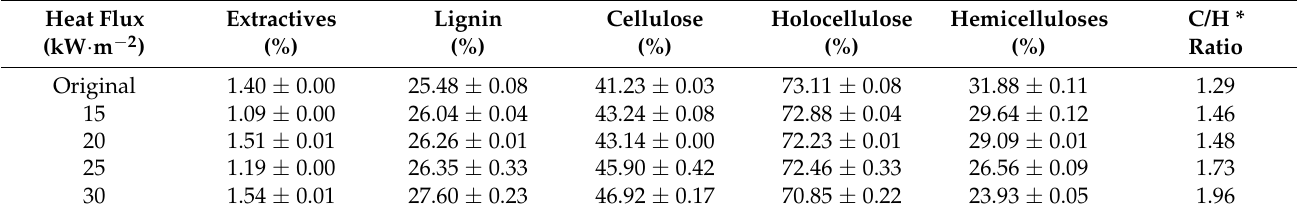
Table 3. Chemical composition of the spruce wood before and after thermal loading (relative